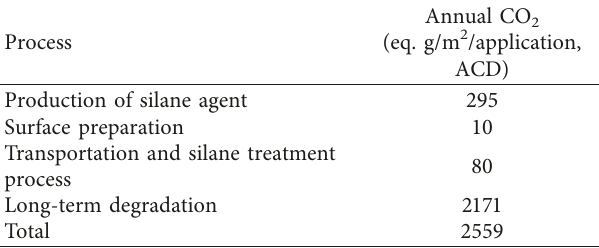
Table 2: Environmental impacts for each silane